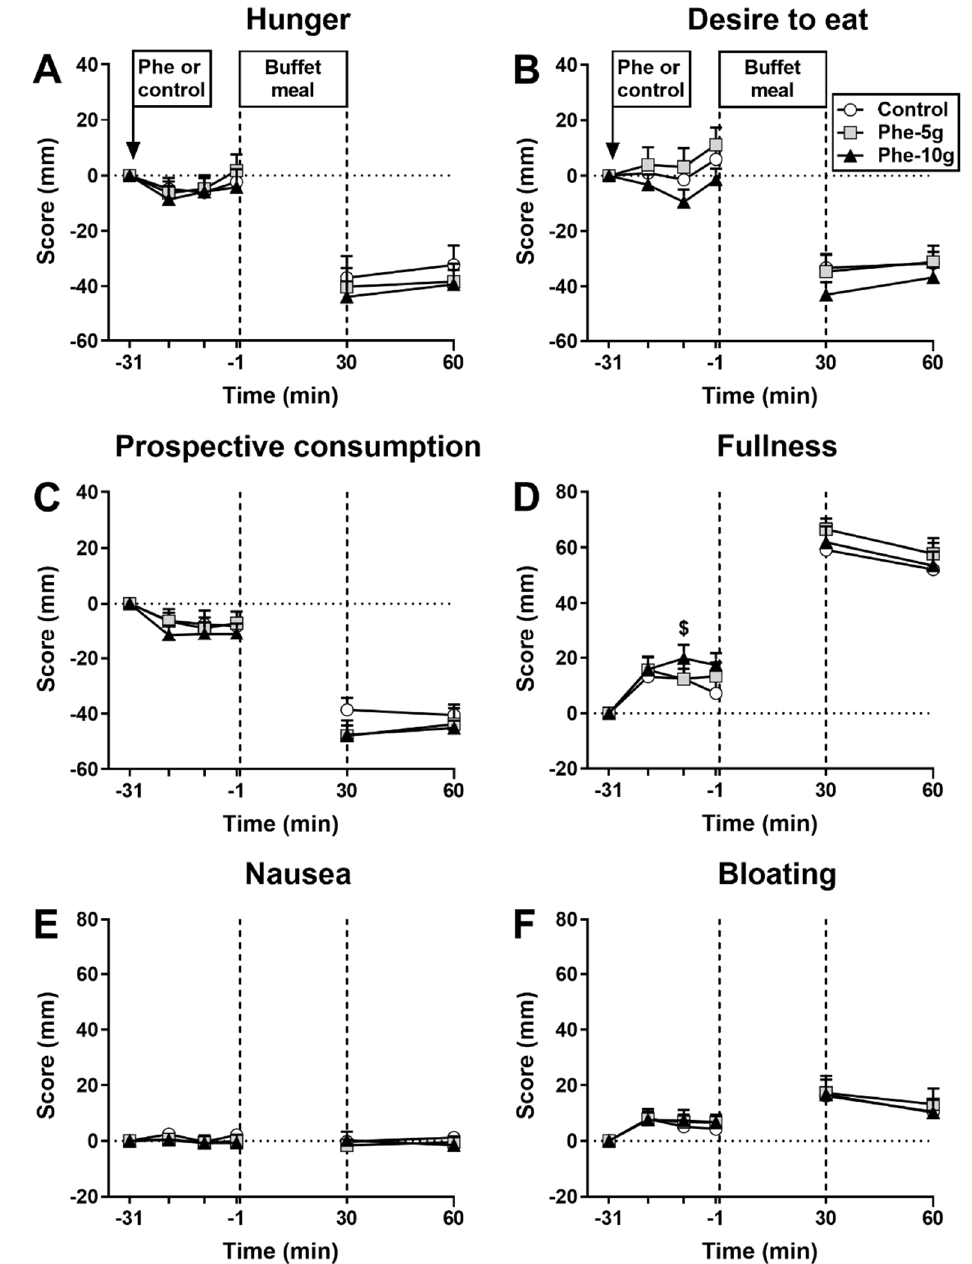
Figure 2. Hunger ( A ), desire to eat ( B ), prospective food consumption ( C ), fullness ( D ), nausea ( E ) and bloating ( F ) at baseline (t = − 31 min), in response to an intragastric bolus (100 mL) of phenylalanine, at doses of 5 g (Phe-5 g) or 10 g (‘Phe-10 g), or control (t = − 20, − 10, − 1 min) and after a bu ff et-meal (t = 30 and 60 min). Data were analysed using a mixed models analysis, including baseline as a covariate and treatment as a fixed factor. Post hoc comparisons, adjusted for multiple comparisons by Bonferroni’s correction, were conducted when the mixed models analysis revealed significant e ff ects. ( D ) Fullness AUC − 31 to − 1 min : $ Phe-10g significantly di ff erent from control ( p = 0.018). Data are means ± SEM and shown as changes from baseline; n = 16.